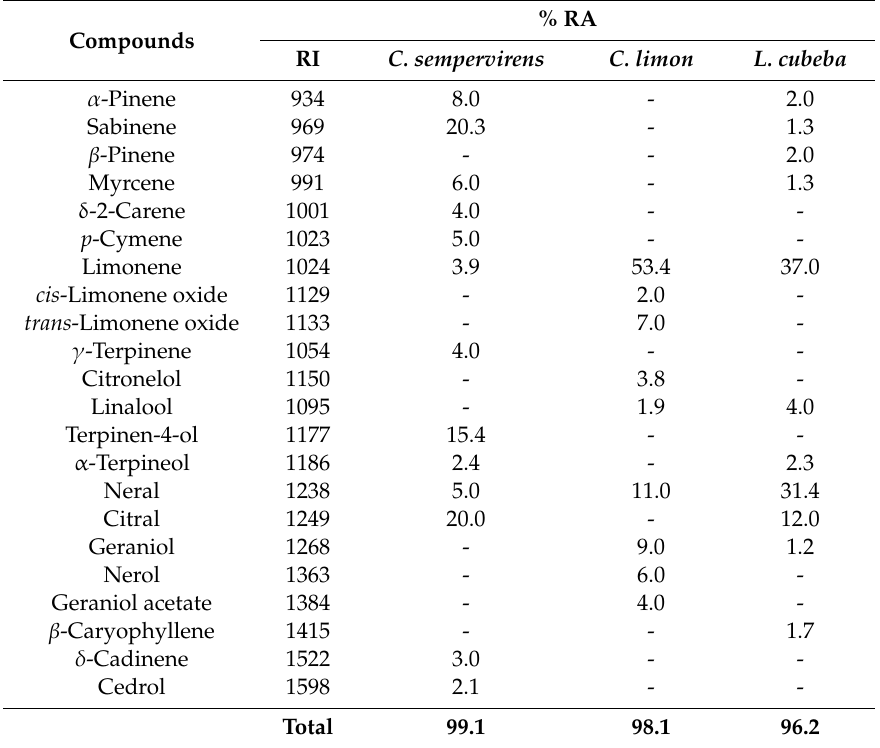
Table 4. Chemical composition of essential oils (EOs) from Cupressus sempervirens and Citrus limon leaves and Litsea cubeba